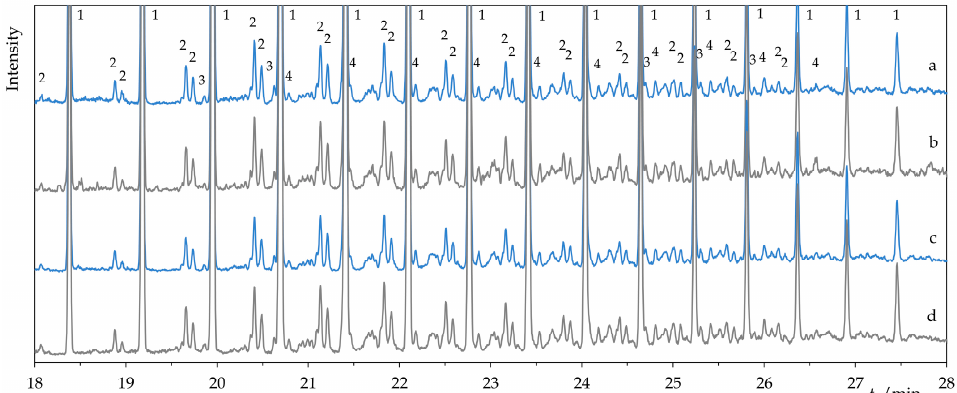
Figure 3 Figure 3. Comparison of the details of chromatograms of Permulgin 3274 ( a ), hydrogenated Per- mulgin 3274 ( b ), UV aged Permulgin 3274 ( c ) and UV aged hydrogenated Permulgin 3274 ( d